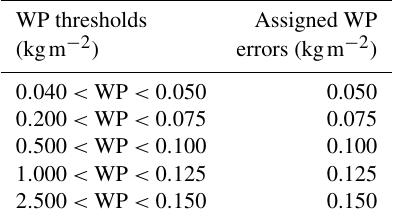
Table 2. Assigned WP retrieval errors depending on threshold val- ues.